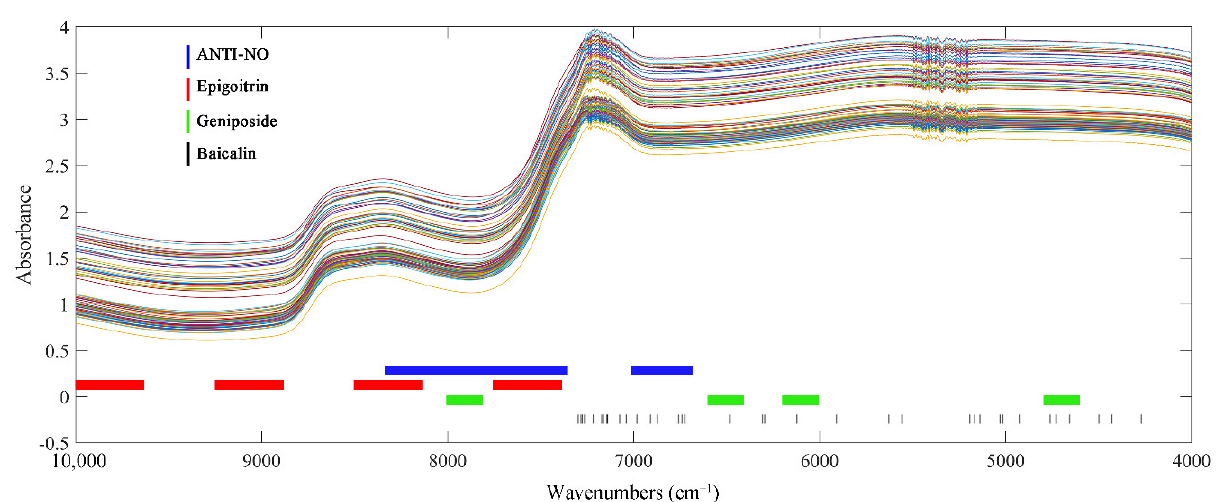
Figure 5. Crucial variables selected of 4 indexes of interest without destroying vial.